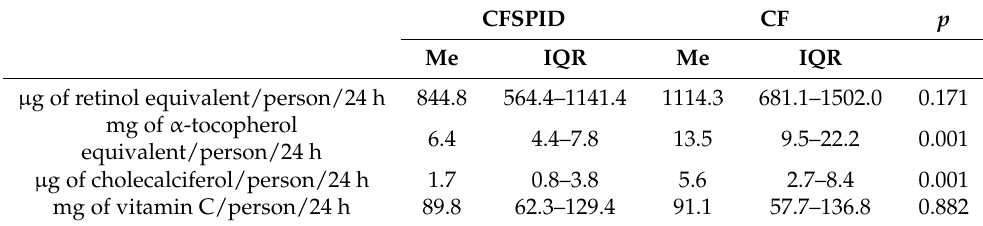
Table 5. Correlation between vitamin intake (diet and supplementation) and blood vitamin concen- tration in the